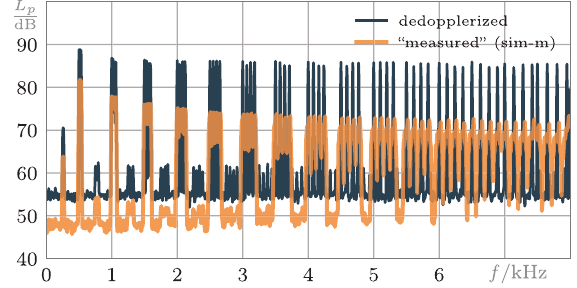
Figure 8. Narrow band spectrum ( D f = 6.25 Hz) of the simulated moving